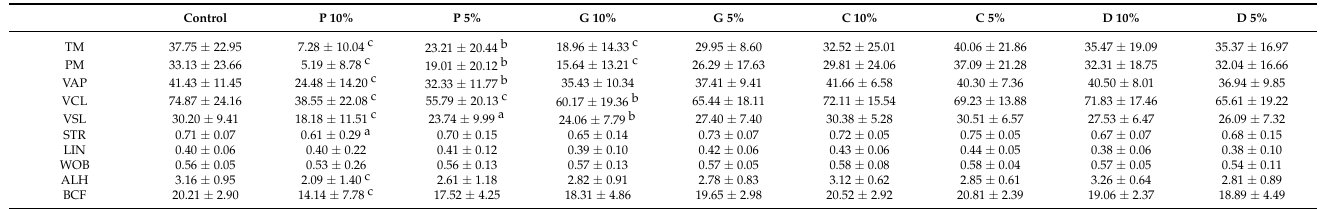
Table 2. CASA parameters of bull semen samples after exposure to various plant-based substances at Time 2.